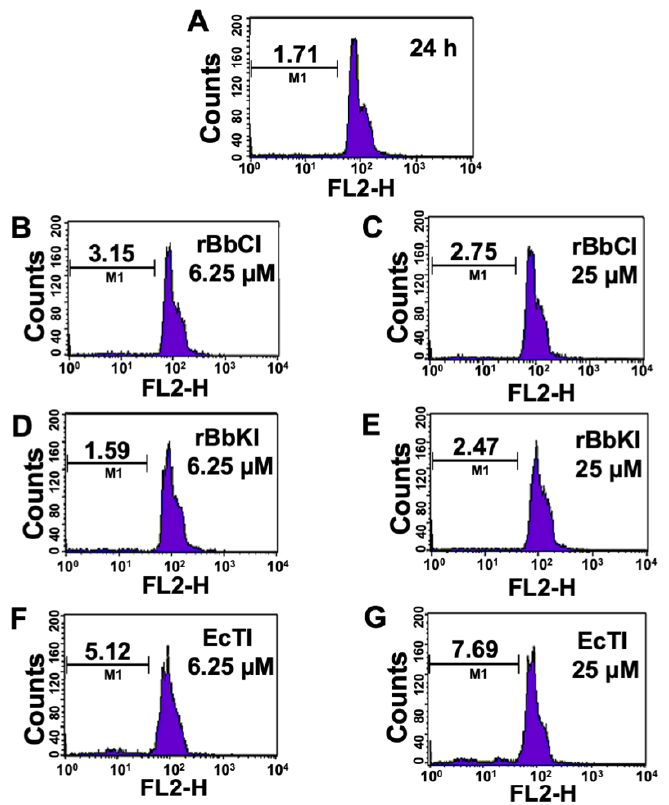
Figure 3. Effect of rBbCI, rBbKI, and EcTI on L929 cell cycle after 24 h incubation. L929 cells treated with ( A ) control, ( B ) 6.25 µM rBbCI, ( C ) 25 µM rBbCI, ( D ) 6.25 µM rBbKI, ( E ) 25 µM rBbKI, with ( A ) control, ( B ) 6.25 µ M rBbCI, ( C ) 25 µ M rBbCI, ( D ) 6.25 µ M rBbKI, ( E ) 25 µ M rBbKI, ( F ) ( F ) 6.25 µM EcTI, and ( G ) 25 µM EcTI. M1 = fragmented cells. 6.25 µ M EcTI, and ( G ) 25 µ M EcTI. M1 = fragmented